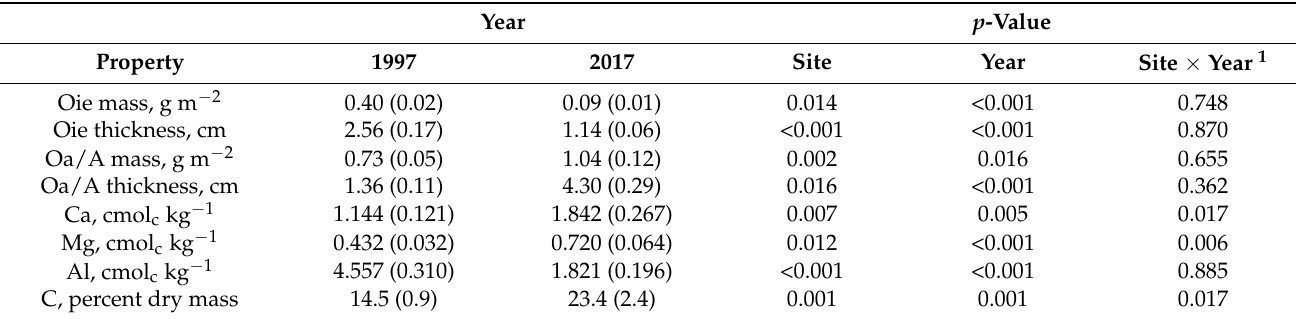
Figure 7. Exchangeable calcium vs. carbon concentration in samples of the E and uppermost B horizons. Color code follows the same scheme for sampling years as the soil profiles (Figures 1–5). Different symbols denote each of the four sampling sites. Table 2. Least squares means (standard error) for mass per area, thickness, exchangeable concentrations of Ca, Mg, Al, and organic carbon content in Oie and Oa/A samples from pin-blocks in 1997 and 2017. Chemical analyses are for the Oa/A sample only. Sample number is 10 pin blocks per site in 1997. In 2017, four pin blocks per quadrant (total 16 pin blocks) were composited to yield 4 measurements per